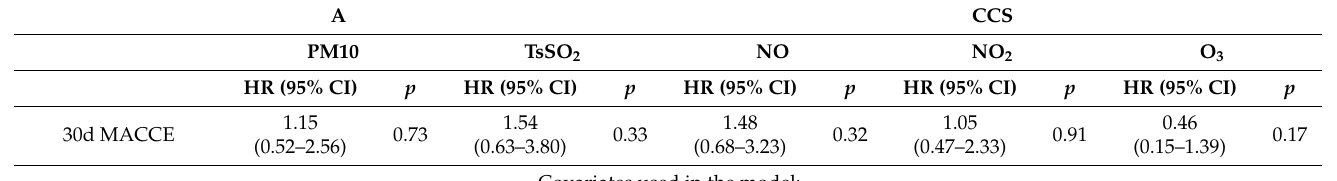
Table 3. The influence of exceeding 3rd quartiles of air pollutants on short- and mid-term outcomes in the chronic coronary syndromes (CCS; A ) and acute coronary syndromes (ACS; B ) subgroup. Ab- breviations: BMI, body mass index; CAD, coronary artery disease; CCS, chronic coronary syndromes; EF, left ventricular ejection fraction; MACCE, major adverse cardiovascular or cerebrovascular events; MI, myocardial infarction; NO, nitric oxide; NO 2 , nitric dioxide; O 3 , ozone; PM10, particulate matter with aerodynamic diameter < 10 um; SBP, systolic blood pressure; SO 2 , sulfur dioxide; U-PCI, urgent percutaneous coronary intervention; WBC, white blood cells